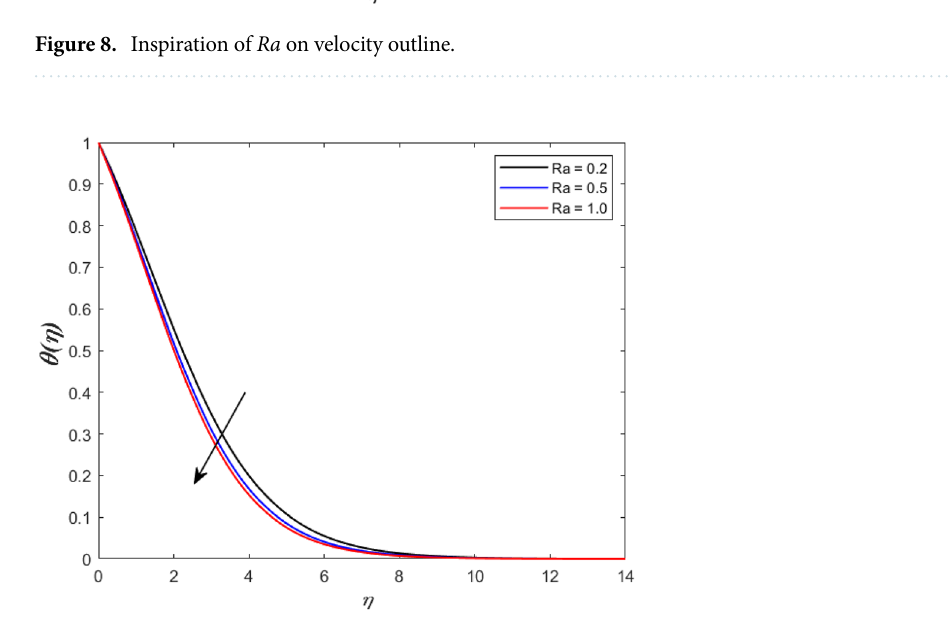
Figure 9. Inspiration of Ra on temperature